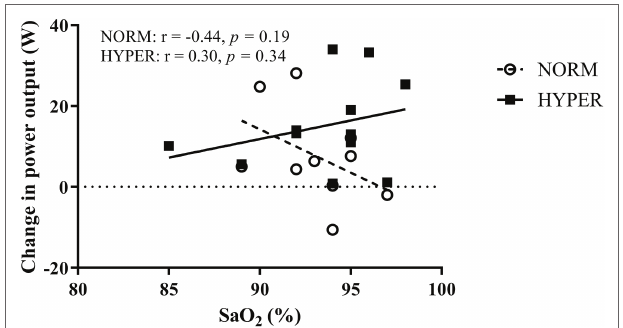
FIGURE 5 | Relationship between the change in power output during the 20-min self-paced cycling test over the training intervention and the mean arterial oxygen saturation (SaO 2 ) measured during the same test in participants in normoxia (NORM) and hyperoxia (HYPER)